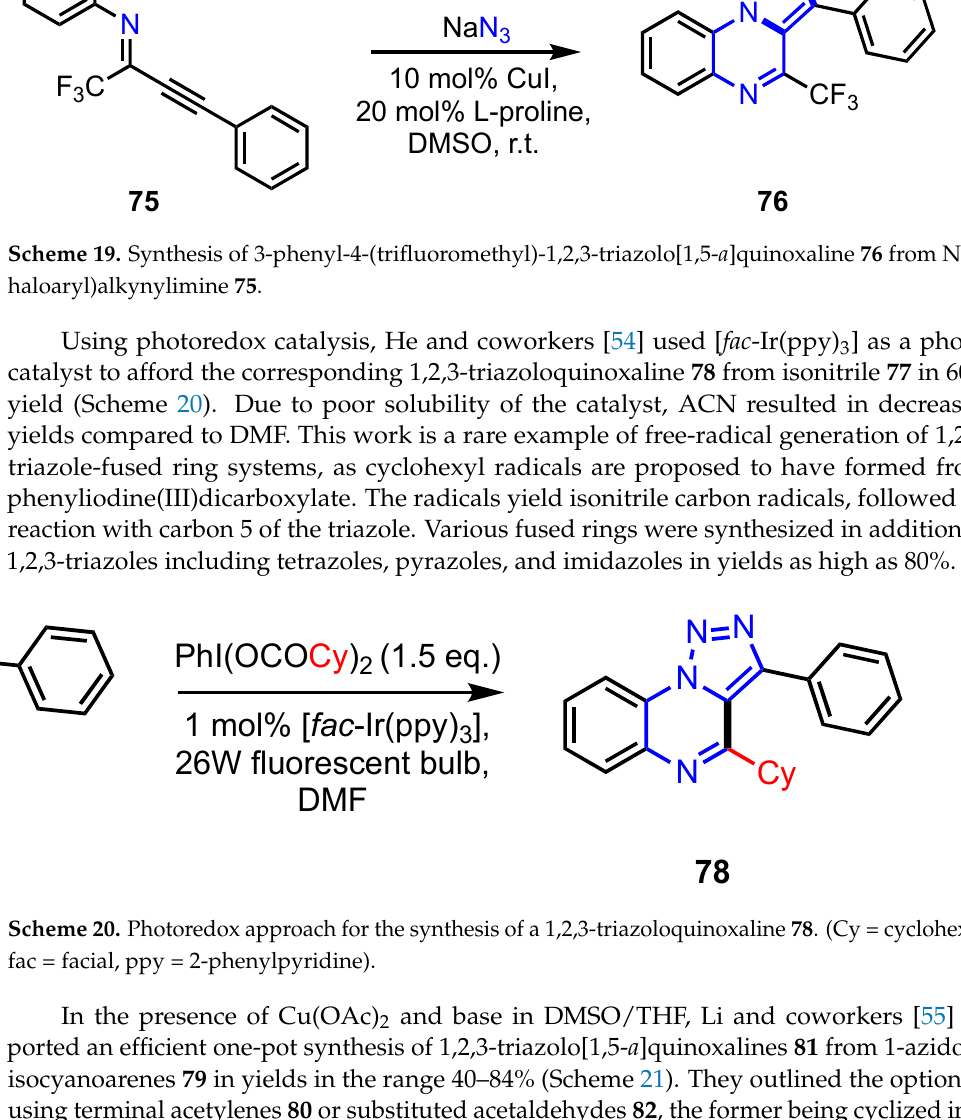
Scheme 18. 3-Phenyl-4- p -tolyl-1,2,3-triazolo[1,5- a ]quinoxalines 74 synthesized from ortho -substi- tuted 2-(4-phenyl-[1,2,3]triazol-1-yl)anilines 72 . (R 1 , R 2 = alkyl or aryl.)